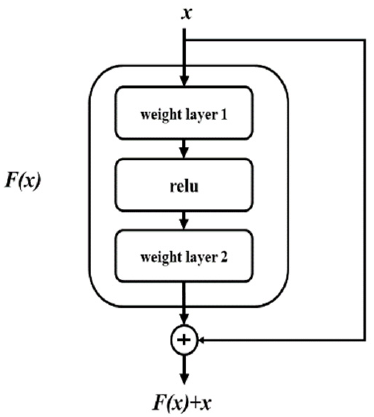
Figure 6. A schematic diagram of the residual principle. F(x) is a two-layer network without jump connection. The residual block can then be expressed as H(x) = F(x) + x . The residual network is helpful to solve the problem of gradient disappearing and gradient exploding so that we can train a deeper network and guarantee good performance at the same time. The concept of residual is also introduced into the